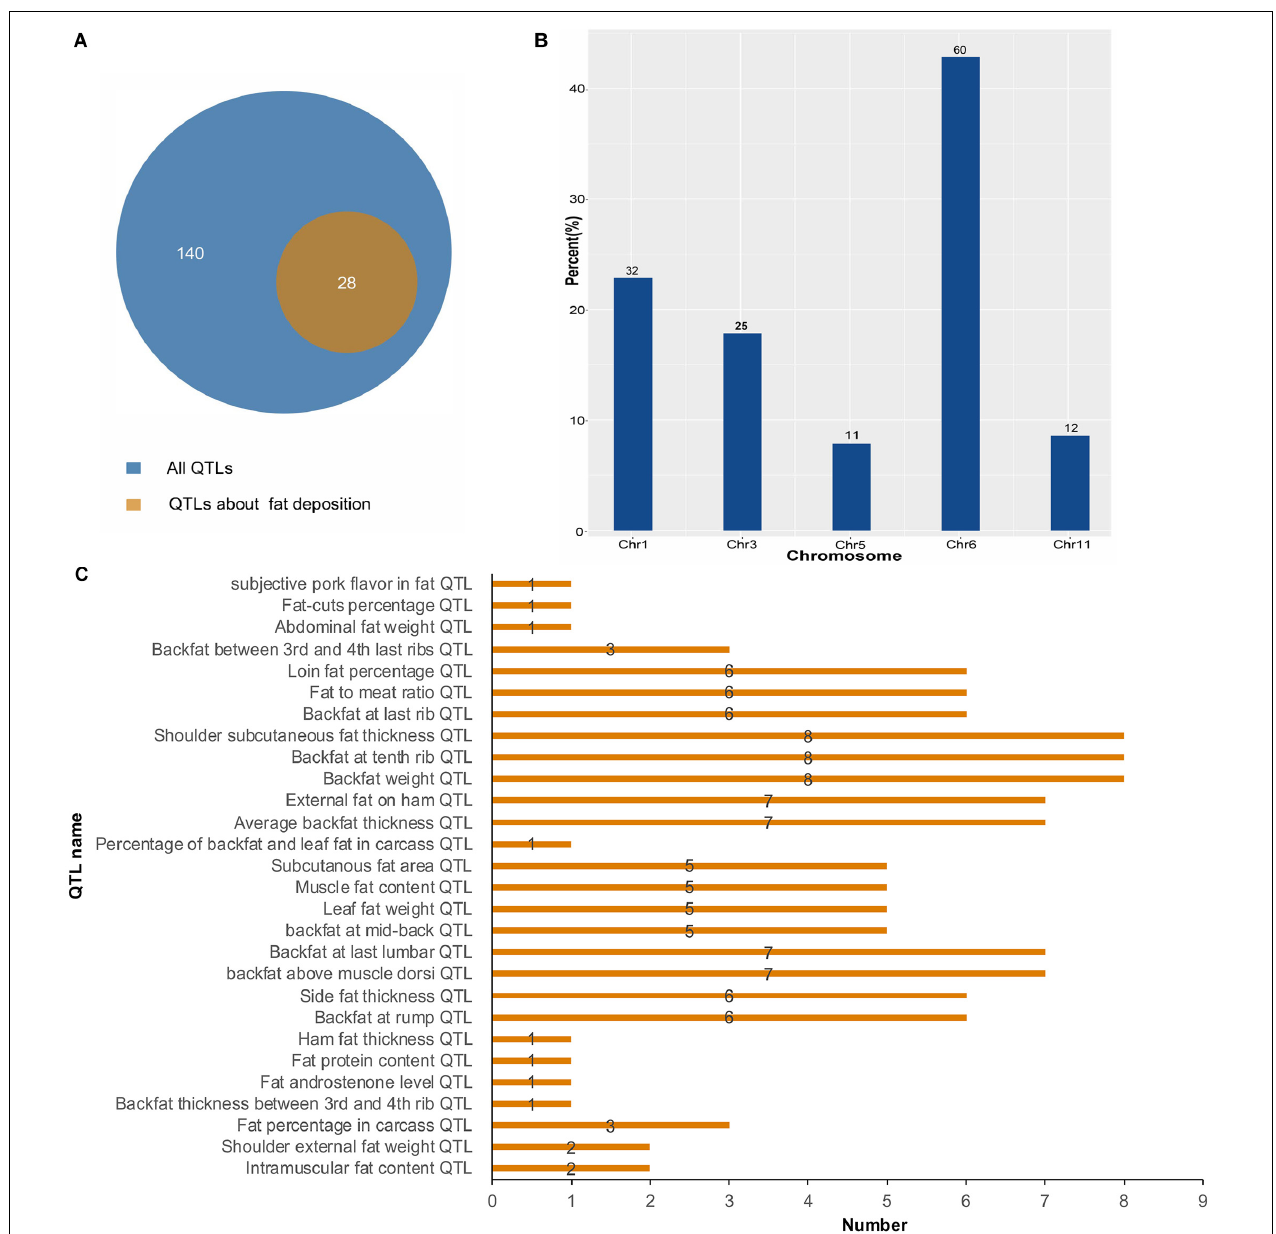
FIGURE 5 | Quantitative trait locus mapping analysis of DELs. (A) The number distribution of different QTLs. (B) The quantitative distribution of DELs which were located in QTLs associated with fat deposition. (C) The chromosome distribution of all QTLs.